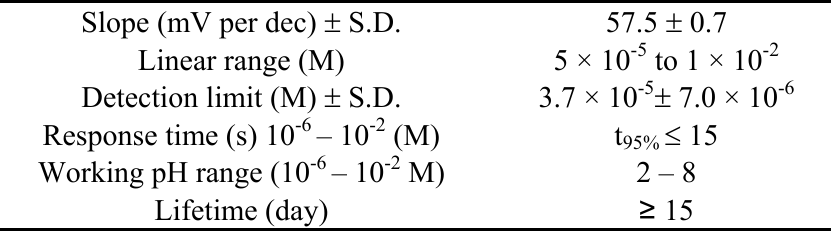
Table 2. Response characteristics of the sulpiride-selective